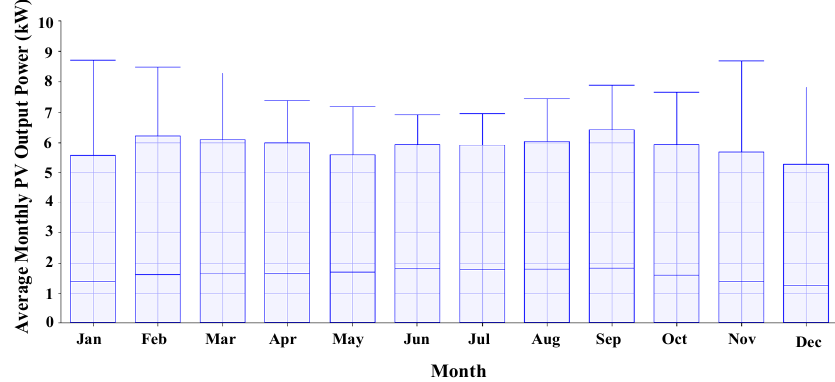
Figure 13. Average monthly PV system output power.